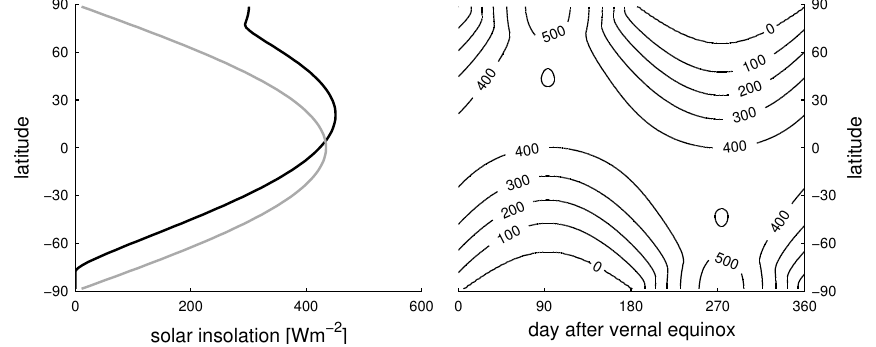
Fig. 1. Solar insolation at the top of atmosphere in Wm − 2 . Left panel: perpetual off-equatorial insolation with maximum at 23.5 ◦ N. For reference, the symmetric equinox profile used in Voigt et al. (2012) is shown in gray. Right panel: seasonally varying insolation profile corresponding to a circular orbit with an obliquity of 23.5 ◦ . A 360-day calendar is applied, with days counted from vernal